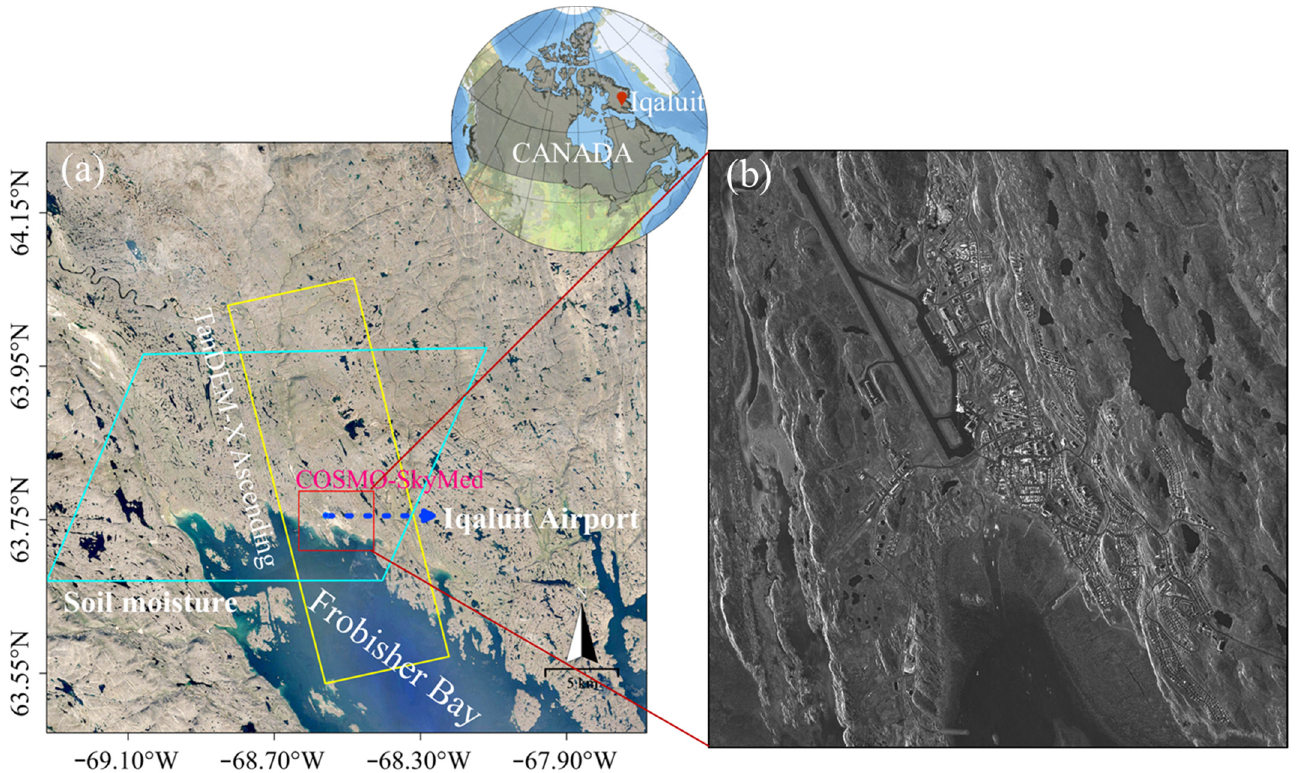
Figure 1. ( a ) Location of the study area and coverage of SAR images and soil moisture; ( b ) a CSK amplitude image.